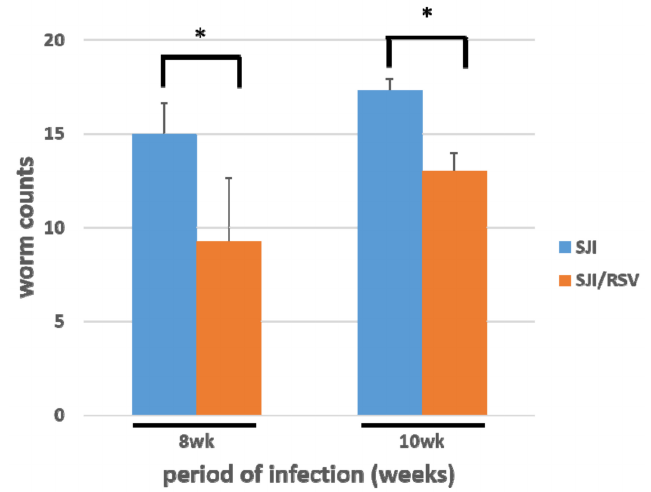
Figure 5. RSV reduces the count of S. japonicum worms obtained from mice at 8 and 10 weeks after infection. The worm count was significantly lower in the RSV-treated group than in the non-treated group at both 8 weeks and 10 weeks. Results are presented as mean ± SD (n = 10 for each group). * p < 0.05, unpaired Student t